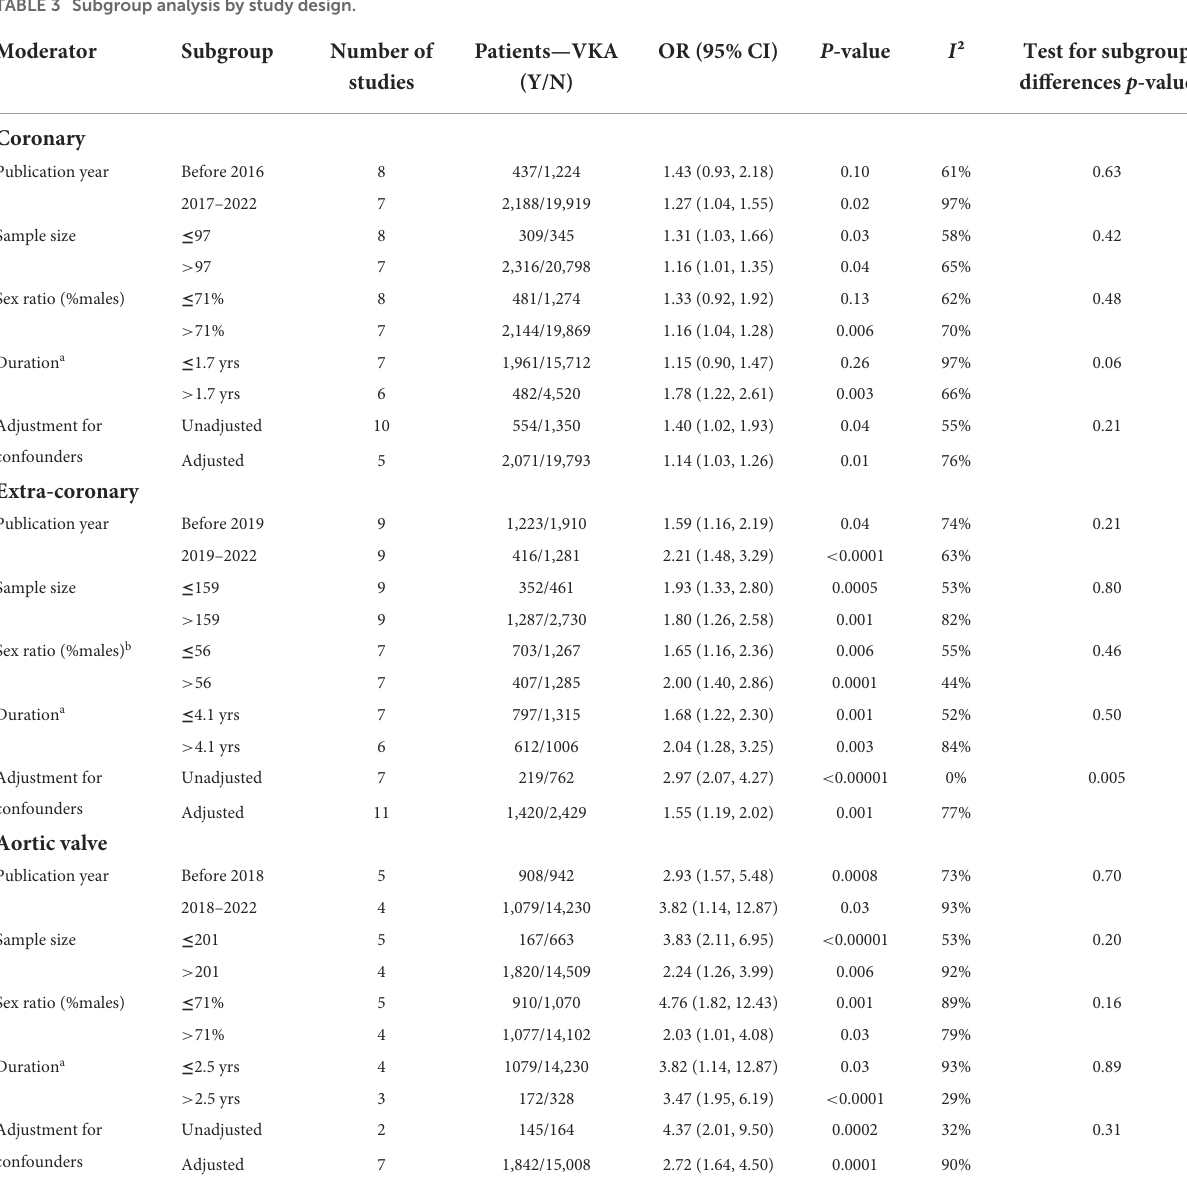
TABLE 3 Subgroup analysis by study